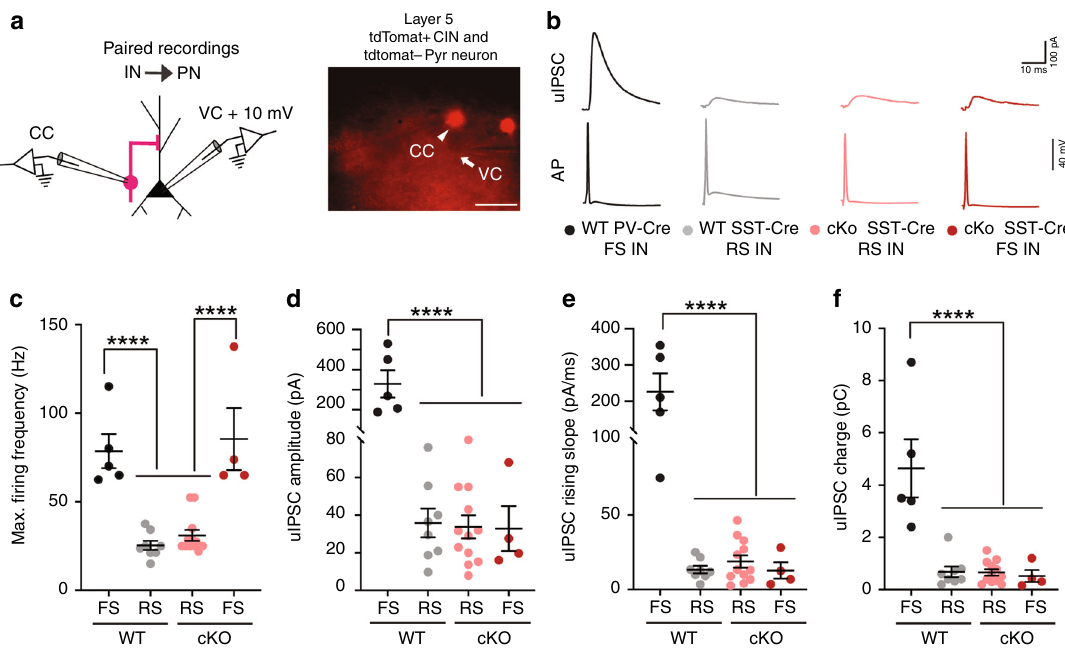
Fig. 6 FS/ SST-Cre CINs in Tsc1 cKOs send their outputs to distal dendrites of pyramidal neurons. a Left, Experimental design: Simultaneous recordings were obtained from connected layer 5 tdTomato + CINs, (current clamp, CC) and pyramidal neurons, (voltage clamp, VC), + 10 mV. Right, representative image showing patch pipettes targeting tdTomato + CIN (arrowhead) and tdTomato − pyramidal neuron (arrow). Scale bar is 50 µ m. b Example unitary inhibitory post synaptic currents (uIPSCs) recorded in pyramidal neurons generated in response to action potentials (AP) in WT FS/ PV-Cre CINs (black, 5 pairs), WT RS/ SST-Cre CINs (grey, 8 pairs), cKO RS/ SST-Cre CINs (salmon, 12 pairs) and cKO FS/ SST-Cre CINs (red, 4 pairs). c Maximum fi ring frequency of four groups of CINs is compared: One-way ANOVA with Tukey ’ s test: (F 3, 25 = 20, P < 0.0001; FS vs. RS p < 0.0001). d – f uIPSC amplitude, rising slope and total charge is compared. One-way ANOVA with Tukey ’ s test, uIPSC amplitude ( d ): (F 3, 25 = 29, P < 0.0001; WT FS/ PV-Cre vs. all groups p < 0.0001); rising slope ( e ): (F 3, 25 = 28.11, P < 0.0001; WT FS/PV-Cre vs. all groups p < 0.0001); and total charge ( f ): (F 3, 25 = 18, P < 0.0001; WT FS/PV-Cre vs. all groups p < 0.0001). Data are presented as mean ± S.E.M. **** p < 0.0001. Source data are provided as a Source Data fi